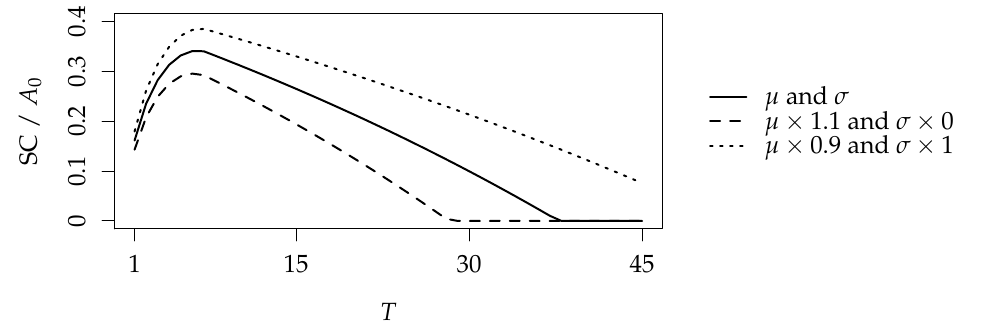
Figure 6. Computation of the solvency capital in the proportion of the initial value of the portfolio according to the iterated VaR measure with α (SII),2 and with different values for µ and σ , for maturities T ∈ { 1, . . . ,45 } and a long-term threshold K =